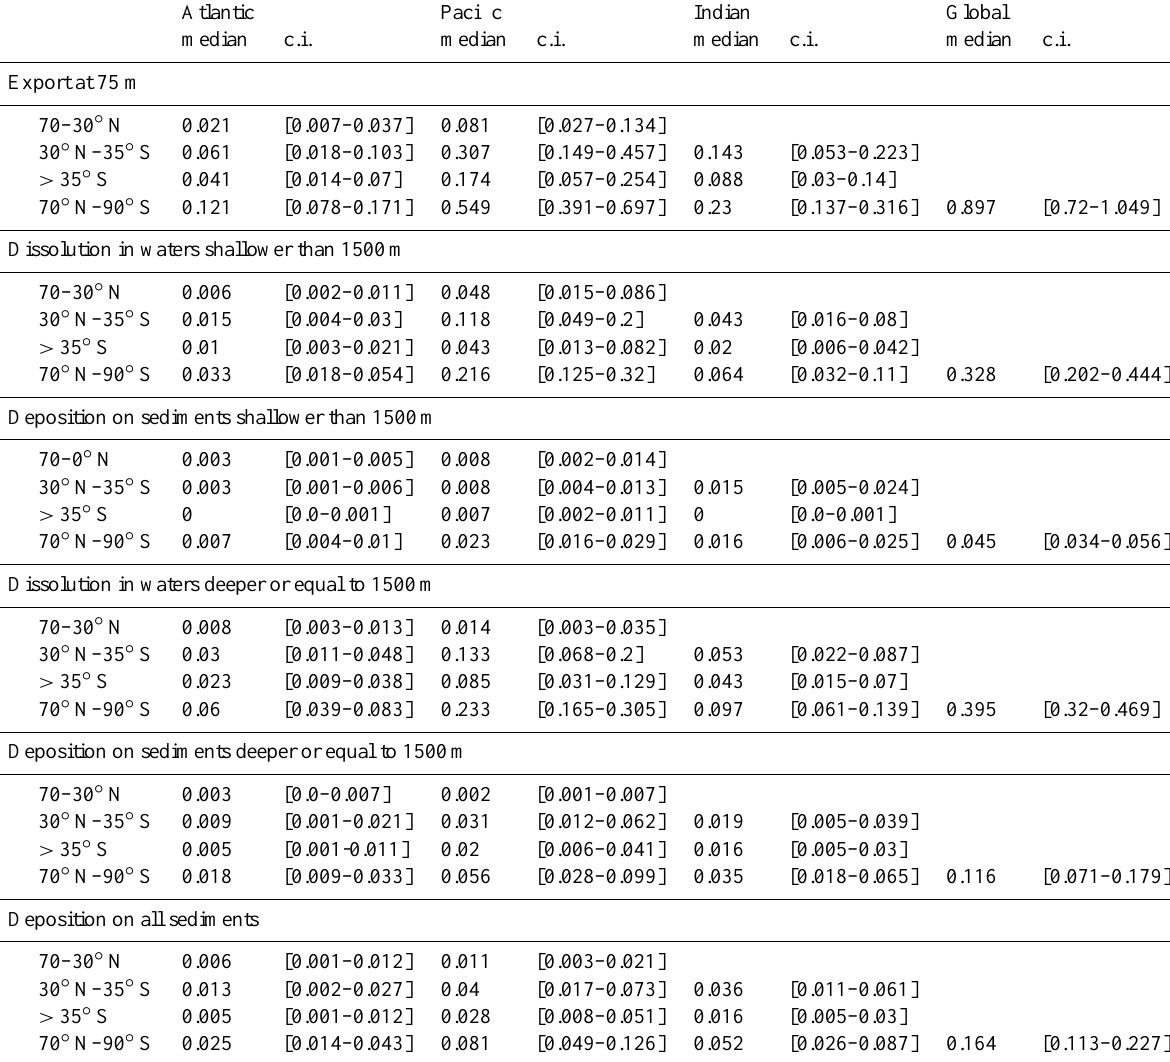
Table 4. Constrained fluxes (median and 68% confidence interval, c.i.) of biogenic CaCO 3 (Gt Cyr − 1 ).